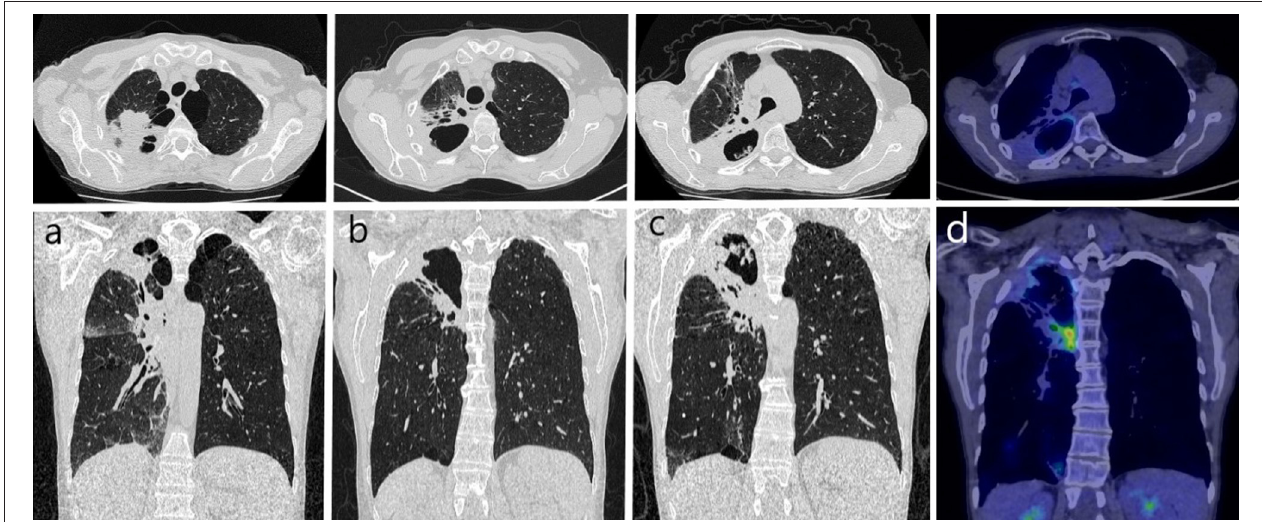
FIGURE 1 | Chest CT in years 2016–2020: (a) 2016 - 3 months after chemoradiotherapy: solid tumor in the upper lobe of the right lung, emphysema in the apical parts of both lungs; (b) 2018 - cavity with the thick wall has formed at the site of the tumor in the right lung; (c) 2020 - progression of an irregular cavity in the upper part of the right lung with thick walls (concomitant mass on the posterior wall), surrounded by solid consolidation, dilated bronchus, and emphysema; (d) 2020 - positron emission tomography combined with computed tomography: unclear character of hypermetabolic masses in the right lung, more likely inflammatory, SUVmax = 2.5.